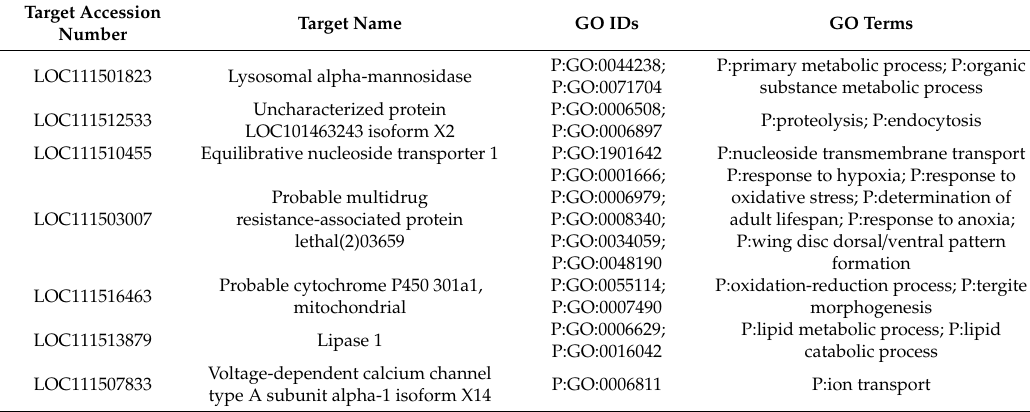
Table 6. Processes associated with select spinosad-modulated mRNA transcripts in L. decemlineata . L. decemlineata accession numbers and corresponding targets obtained from the dipteran database are